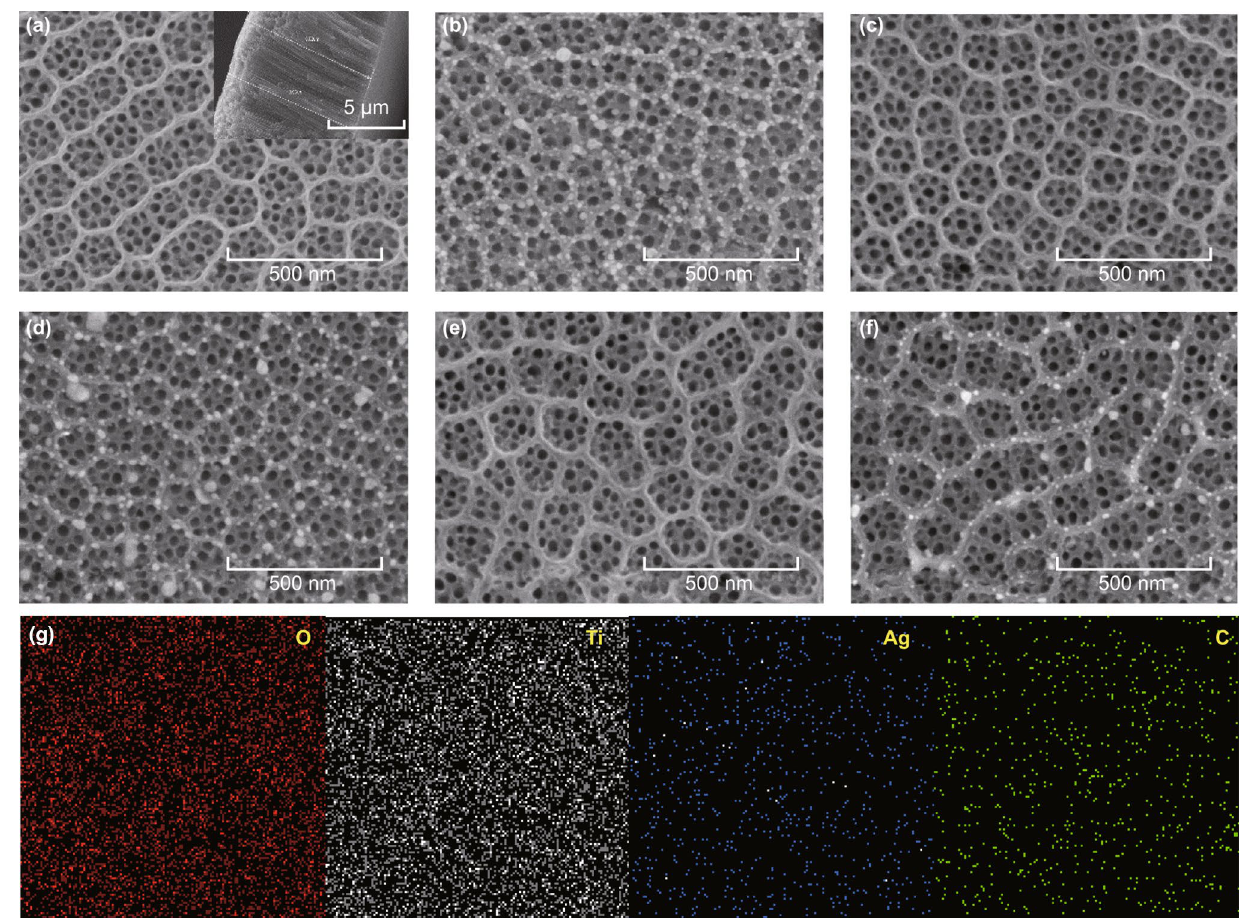
Fig. 4 Top view SEM images of TiO 2 -based nanomaterials of a TiO 2 R/T, b Ag-TiO 2 R/T, c TiO 2 R/T-rGO, d Ag-TiO 2 R/T-rGO, e TiO 2 R-rGO/T, f Ag-TiO 2 R-rGO/T. The inset in a shows the TiO 2 R/T cross-sectional views. g The mapping images of the Ag-TiO 2